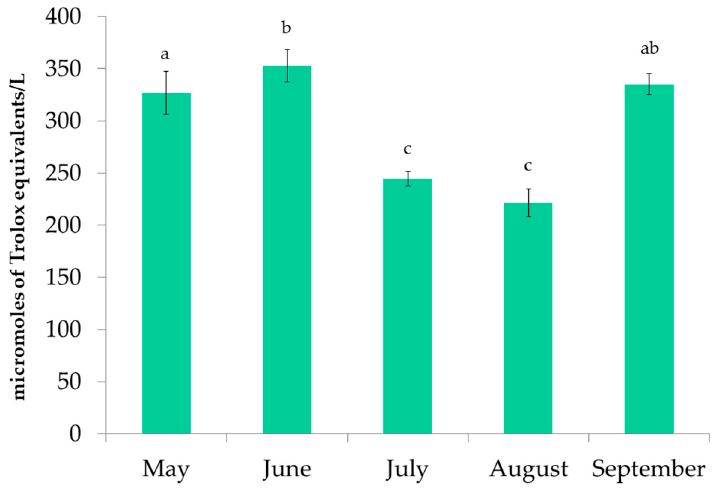
Figure 4. FRAP results for extracts of P. pavonica harvested from May to September. a–c different letters denote statistically significant difference.